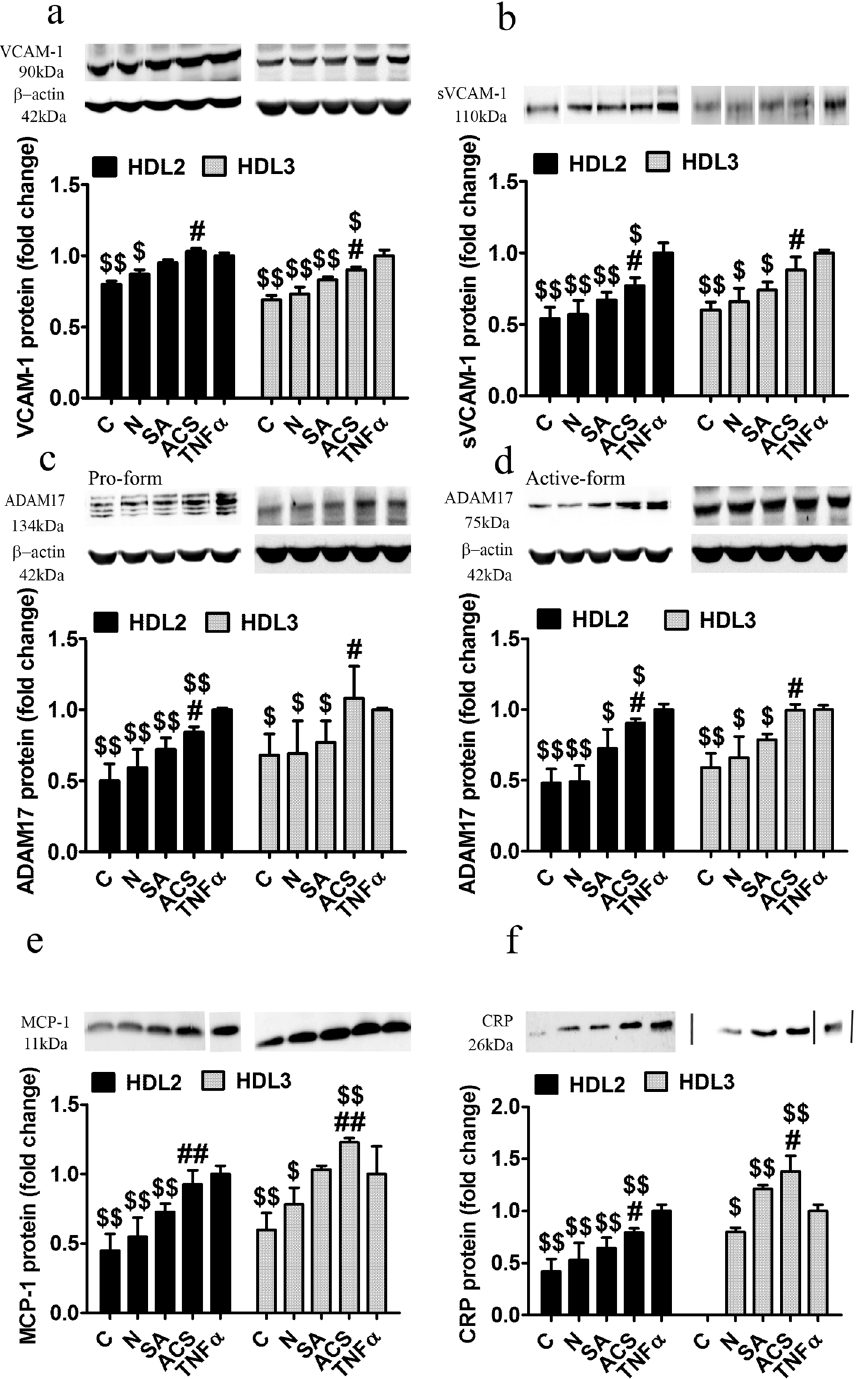
Figure 5. HDL 2 and HDL 3 functionality evaluated by their anti-inflammatory effects on endothelial cells (EC) activated with tumor necrosis factor α (TNF α ). The vascular cell adhesion molecule 1 (VCAM-1) protein relative to β -actin ( a ) and soluble VCAM-1 (sVCAM-1) in the cultured media relative to cellular protein ( b ); protein expression of disintegrin and metalloproteinase domain-containing protein 17 (ADAM17) pro-form ( c ) and active form ( d ) relative to β -actin. Levels of monocyte chemoattractant protein 1 (MCP-1) ( e ) and C reactive protein (CRP) ( f ) secreted in the culture medium relative to cellular protein. All data come from four different experiments and are expressed as fold change versus TNF α -activated EC. C - cells unstimulated with TNF α , N - healthy subjects, SA - stable angina patients, ACS - acute coronary syndrome patients, TNF α - tumor necrosis factor α . The western blot (wb) images for ( b ), ( e ) and ( f ) were processed by cropping the lanes from the same blot and marked by dividing white lines where the order of the samples on wb was different from the one in the graph. The full-length blots are supplied in the Supplementary information. Data are presented as means ± SD and analyzed with Independent Student’s T-test. # p < 0.05, ## p < 0.01 vs. SA, $ p < 0.05, $$ p < 0.01 vs. TNF α